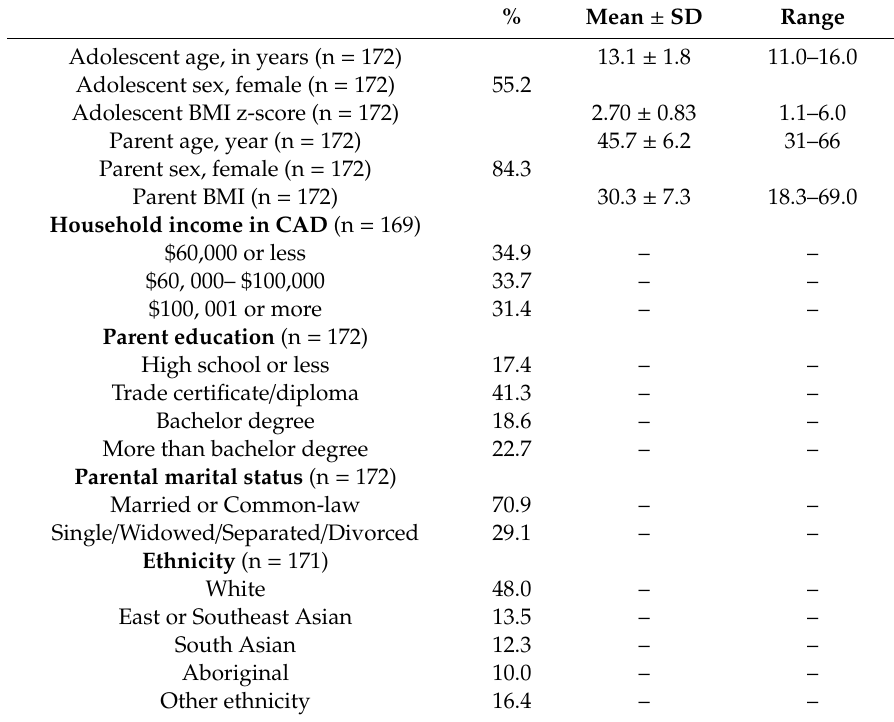
Table 2. Demographic characteristics of adolescents and their parents.